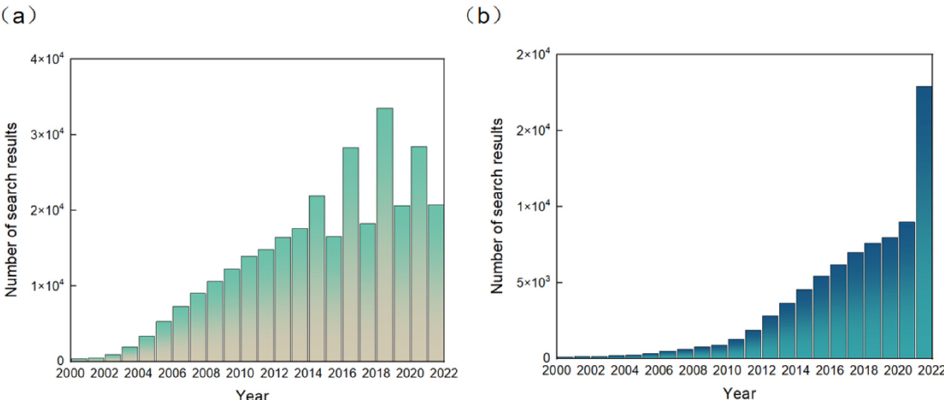
Figure 1. Number of ( a ) search results on Google Scholar in December 2021 according to the keyword “RFID sensors”. Number of ( b ) search results on Google Scholar in December 2021 according to the keyword “NFC sensors”.